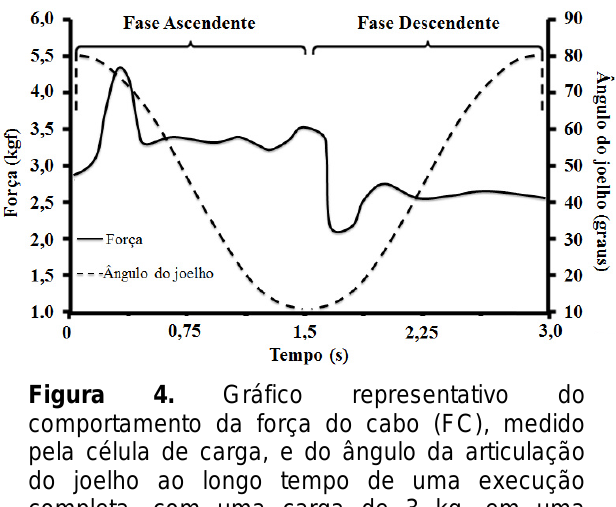
Figura 4. Gráfico